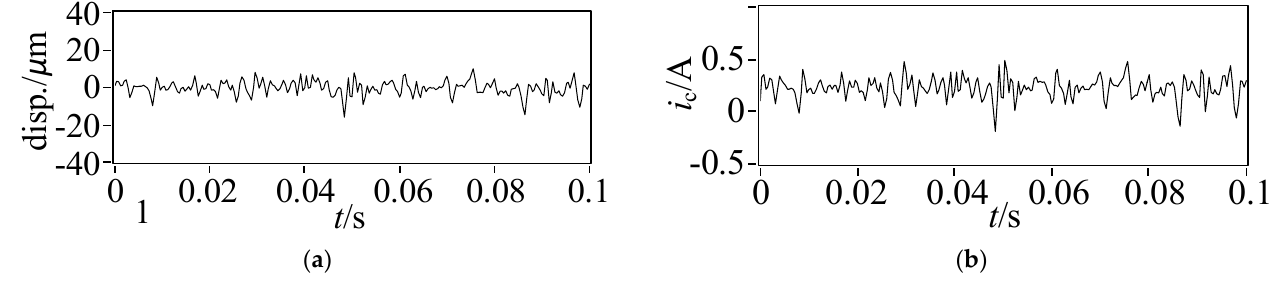
Figure 7. Rotor static suspension displacement and control current. ( a ) displacement diagram; ( b ) current graph.